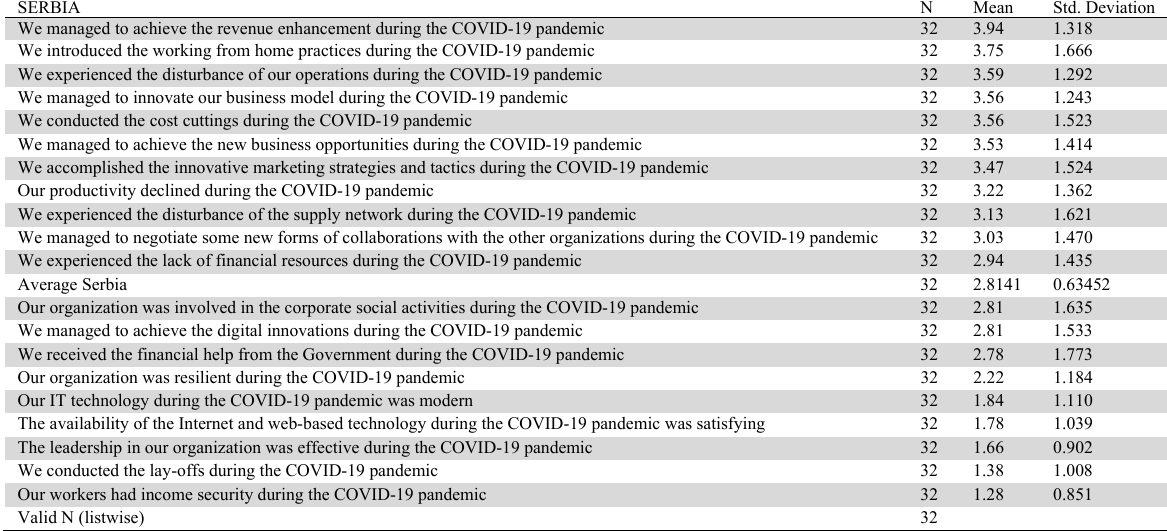
The results of the impact of COVID-19 in Serbia, with variables in descending order SERBIA N Mean Std. Deviation We managed to achieve the revenue enhancement during the COVID-19 pandemic